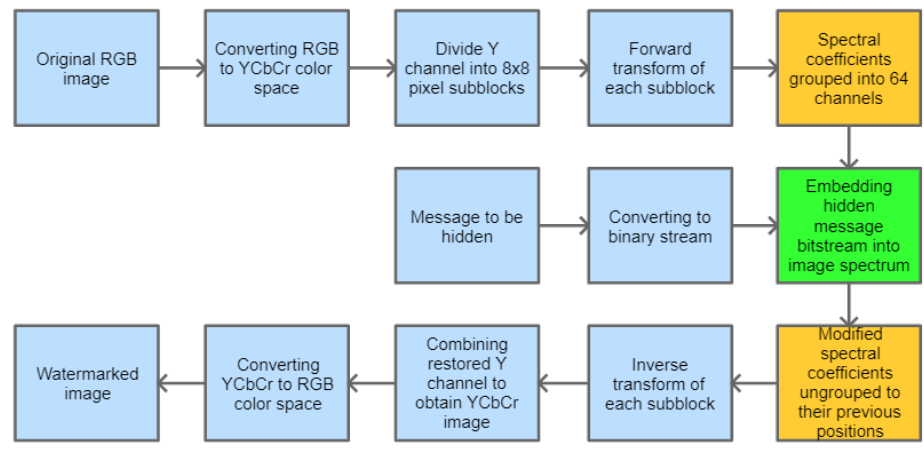
Figure 1. Block diagram for the base process of watermark